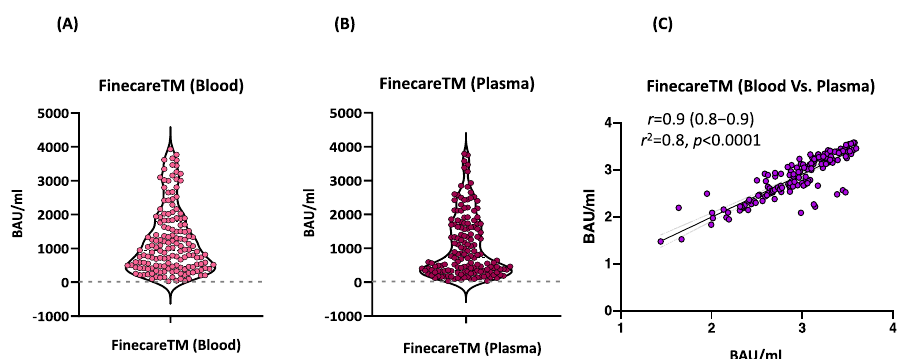
Figure 1. ( A ) Point distribution of fingerstick whole blood samples. ( B ) Point distribution of plasma samples. ( C ) Correlation and linear regression analysis between matched fingerstick whole blood sample and plasma sample using FinecareTM ( n = 156). Pearson correlation coefficient ( r ), coefficient of determination ( r 2 ), and p -value are shown.